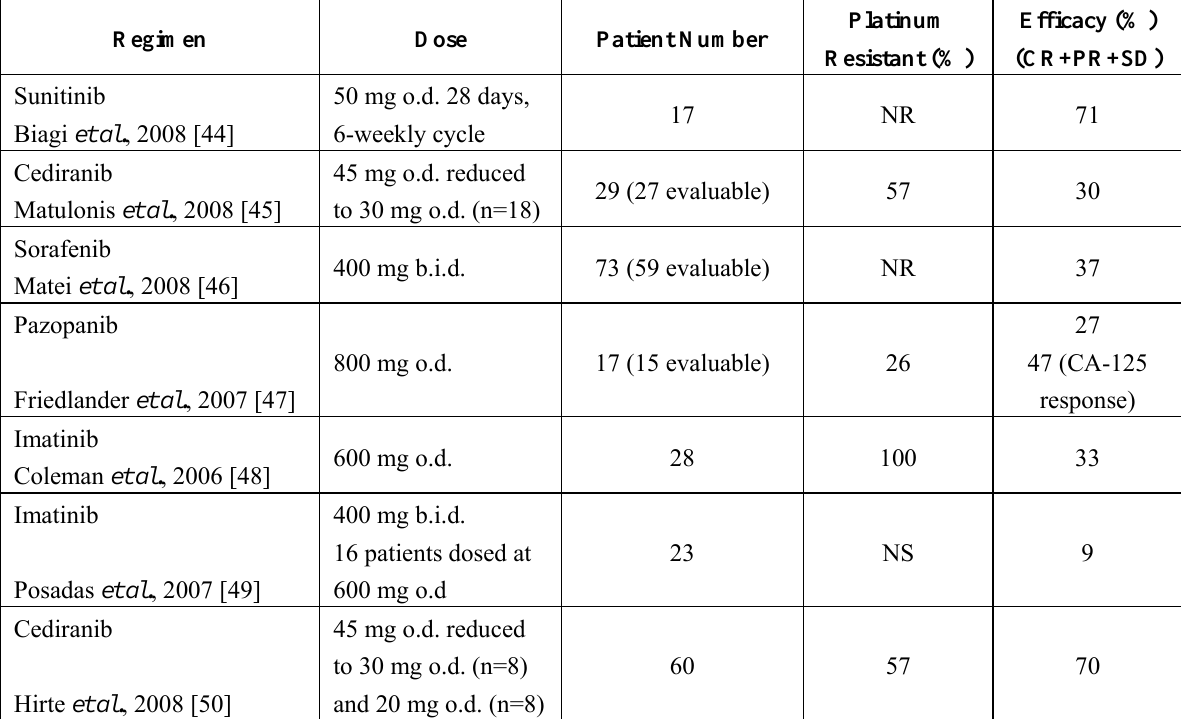
Table 2. Phase II trials of oral VEGFR tyrosine kinase inhibitors in relapsed ovarian cancer.